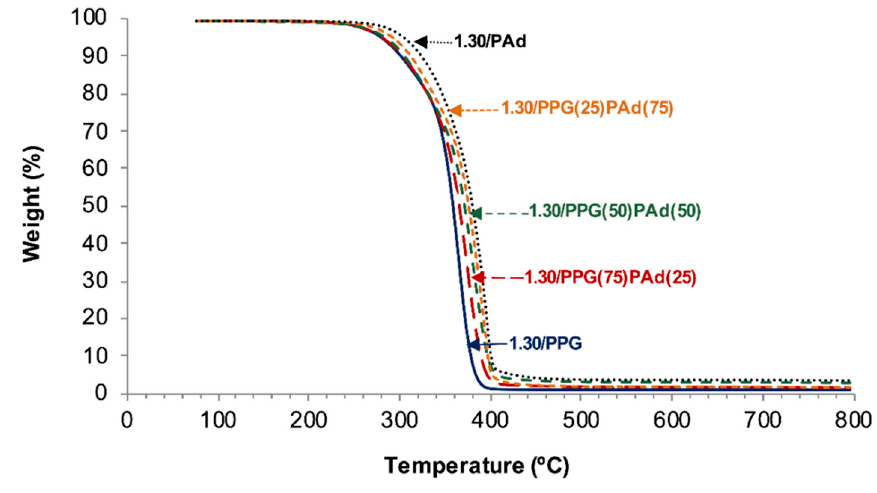
Figure 6. X-ray diffractograms of the TPUs synthesized with PPG+PAd blends. TGA has been used for assessing the structural features of the polyurethanes [37].